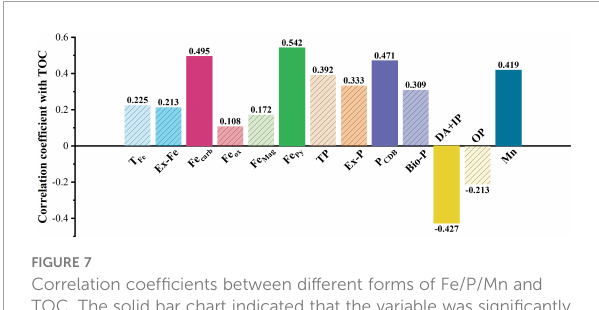
FIGURE 7 Correlation coef fi cients between different forms of Fe/P/Mn and TOC. The solid bar chart indicated that the variable was signi fi cantly correlated with TOC, and the shaded bar chart was not signi fi cantly correlated with